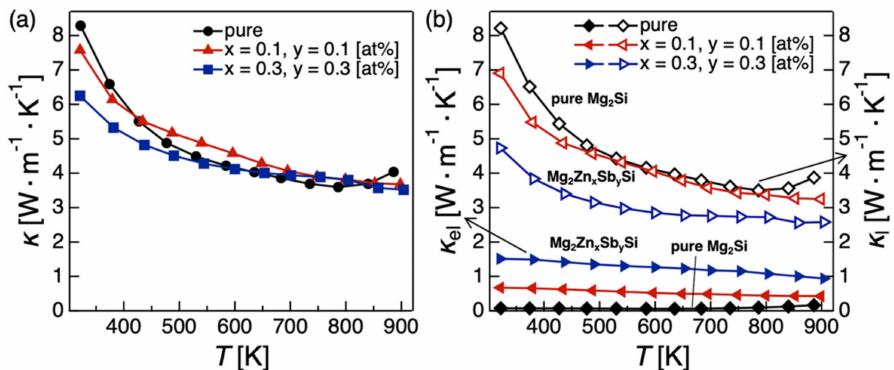
Figure 5. Temperature-dependent ( a ) total thermal conductivity κ , ( b ) electronic thermal conductivity ( κ el ; closed plots), and lattice thermal conductivity ( κ l ; open plots) of Mg 2 MSi (M = Sb, Zn) specimens. (Reprinted by permission from Springer Nature: Springer, Journal of Electronic Materials , “Enhanced thermoelectric performance of vertical Bridgman-grown Mg 2 Si by codoping with Sb and Zn”, D. Shiojiri, T. Iida, H. Hamba, T. Kodama, M. Yamaguchi, N. Hirayama. and Y. Imai, Copyright